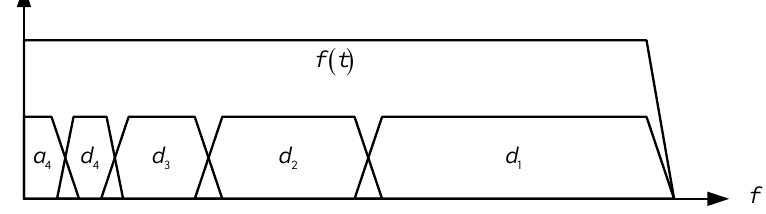
Figure 2. The spectral distribution of wavelet coefficient.